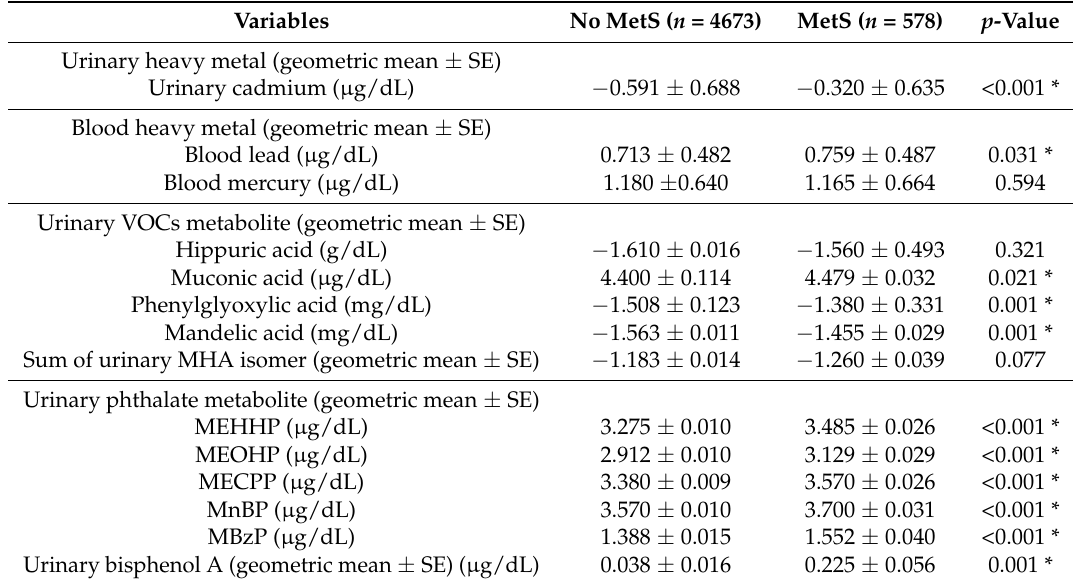
Table 2. Blood and urine hazardous material concentrations by metabolic syndrome (MetS)